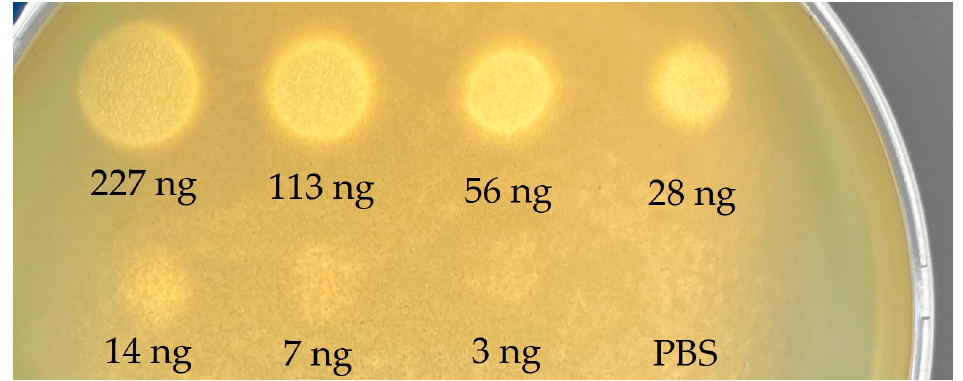
Figure 4. Activity of serially diluted depolymerase Kl-dep on the L2-1B host